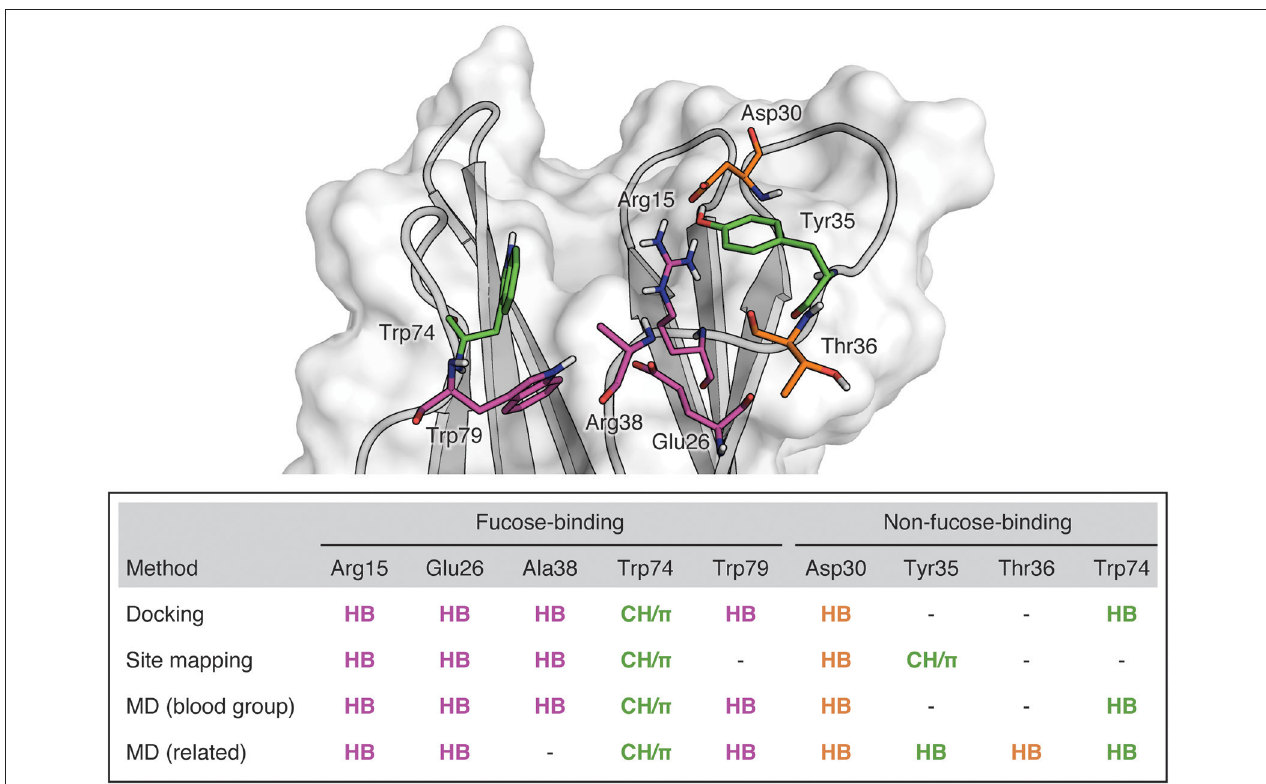
FIGURE 9 | BambL binding site showing residues implicated in saccharide binding. Purple: Residues which form hydrogen bonds with the buried fucose saccharide. Orange: Residues which form hydrogen bonds with non-fucose saccharides. Green: Residues which participate in both hydrophobic and hydrogen bonding